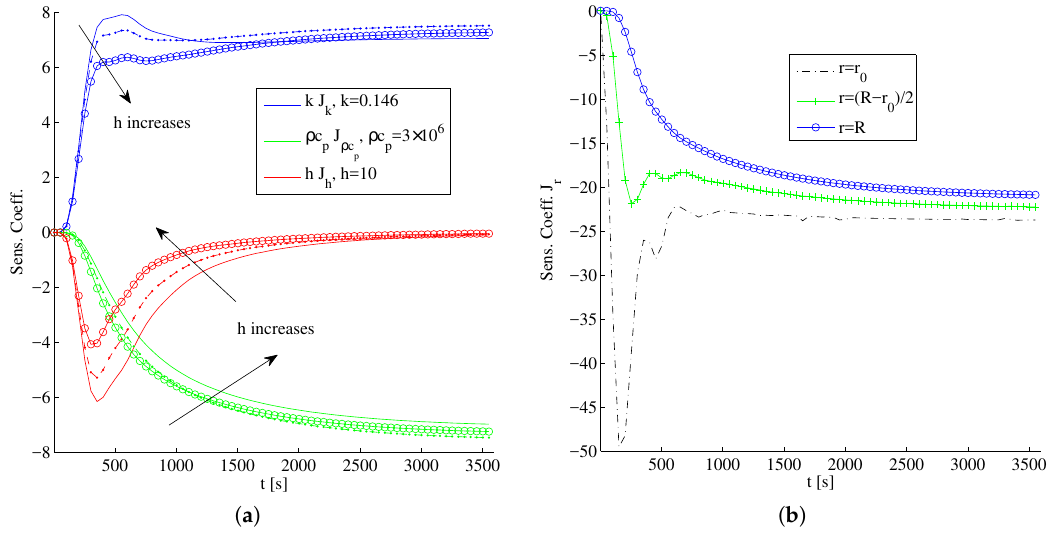
Figure 3. Relative sensitivity coefficients. ( a ) J k , J h and J ρ c temperature with respect to k , h , ρ c p , and r (position within the